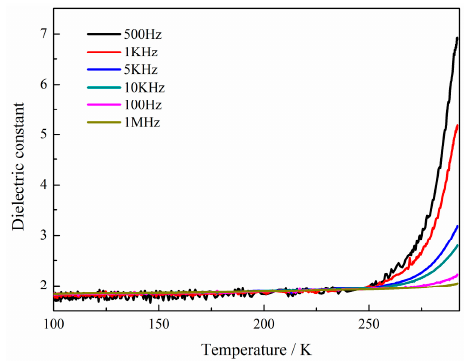
Figure 6. Dielectric constants of compound 1 from 100 K to 300 K at 500 Hz–1 MHz.